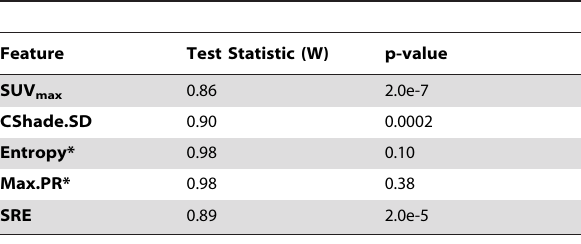
Table 5. Shapiro-Wilk normality test for the selected feature is